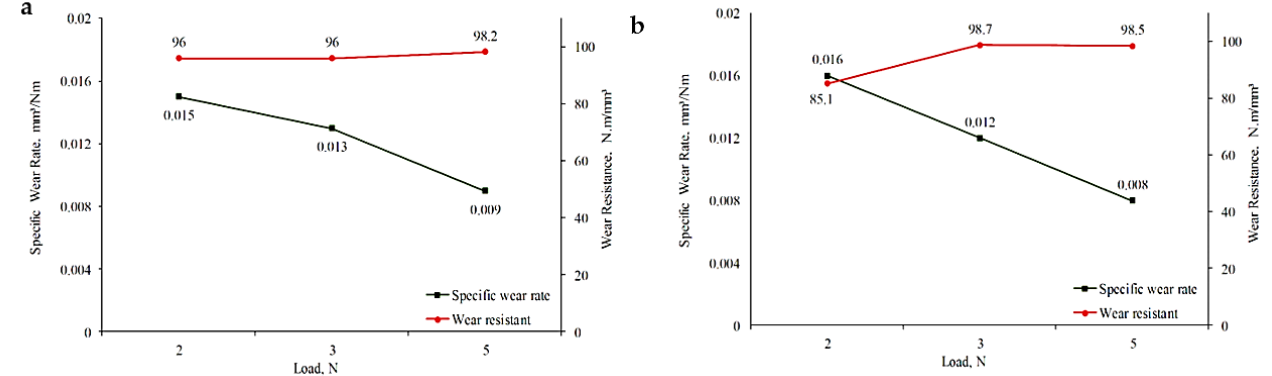
Figure 8. Specific wear rate and wear resistance at 2, 3, and 5 N loads of Al coatings using ( a ) HPCS and ( b ) LPCS.